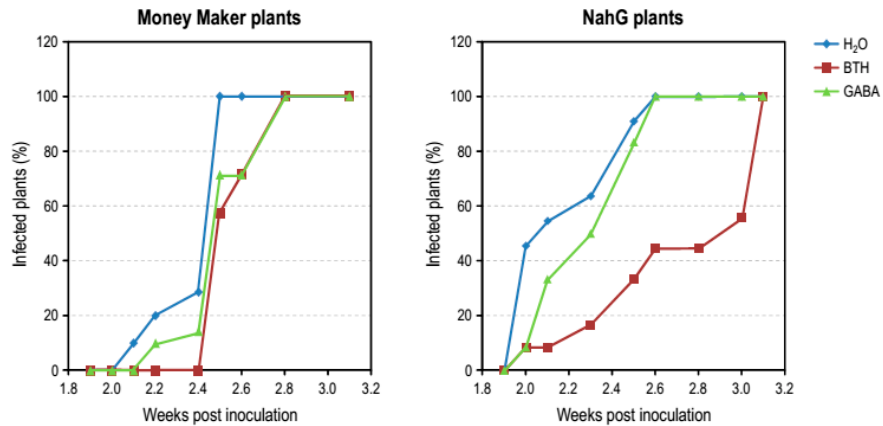
Figure 6. Disease development in Money Maker and NahG plants infected with CEVd and treated with BTH (red), GABA (green) or water (blue). Evolution of tomato plants showing symptoms at the indicated weeks post inoculation. Data correspond to one representative experiment.